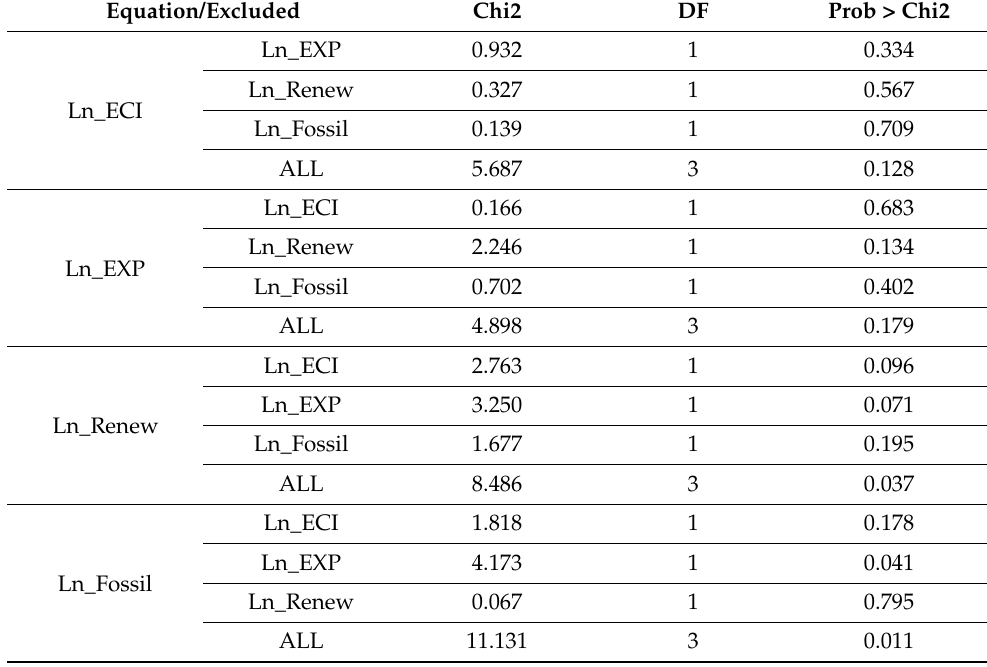
Table 7. Panel Granger test